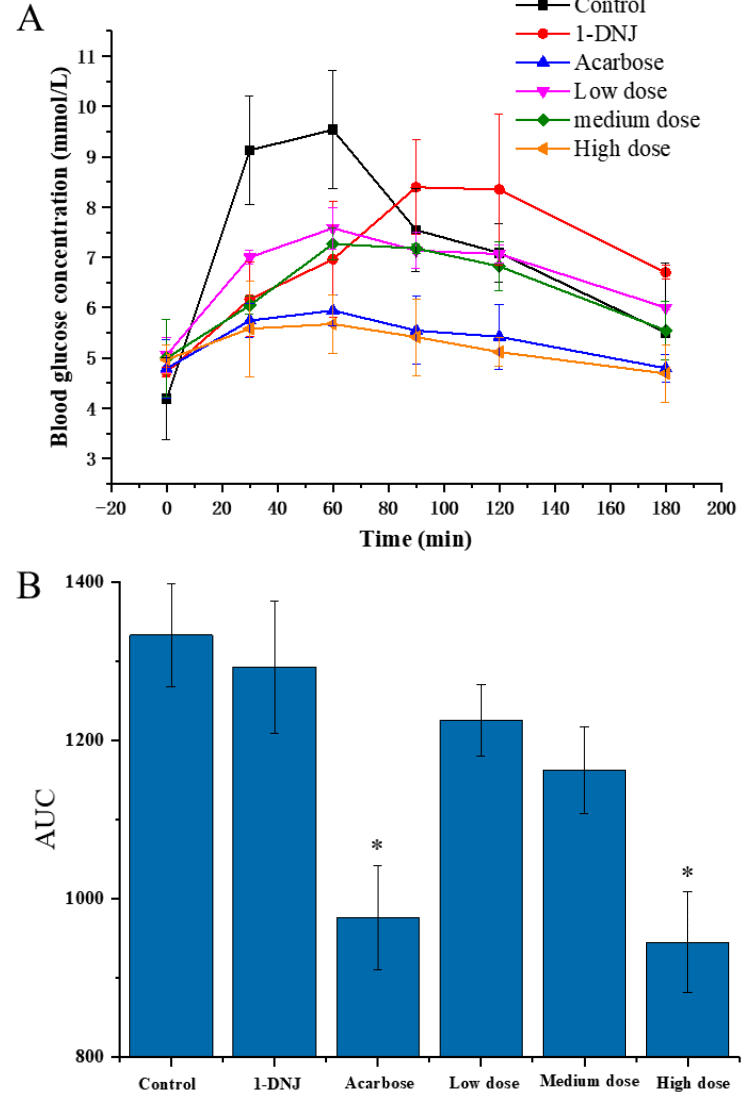
Figure 2. Postprandial blood glucose ( A ) and area under the curve of PBG ( B ) of normal rats treated or untreated by DC-5 at different doses. Where * indicates p ≤ 0.05 when compared with control group.